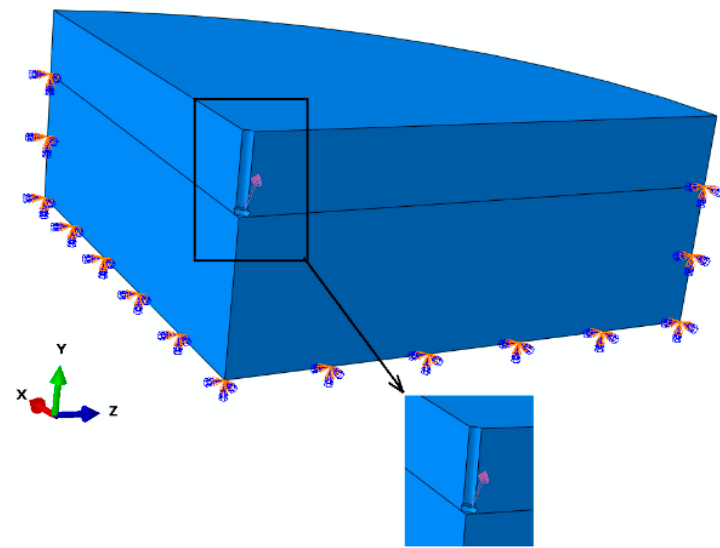
Figure 2. The boundary conditions of the model.